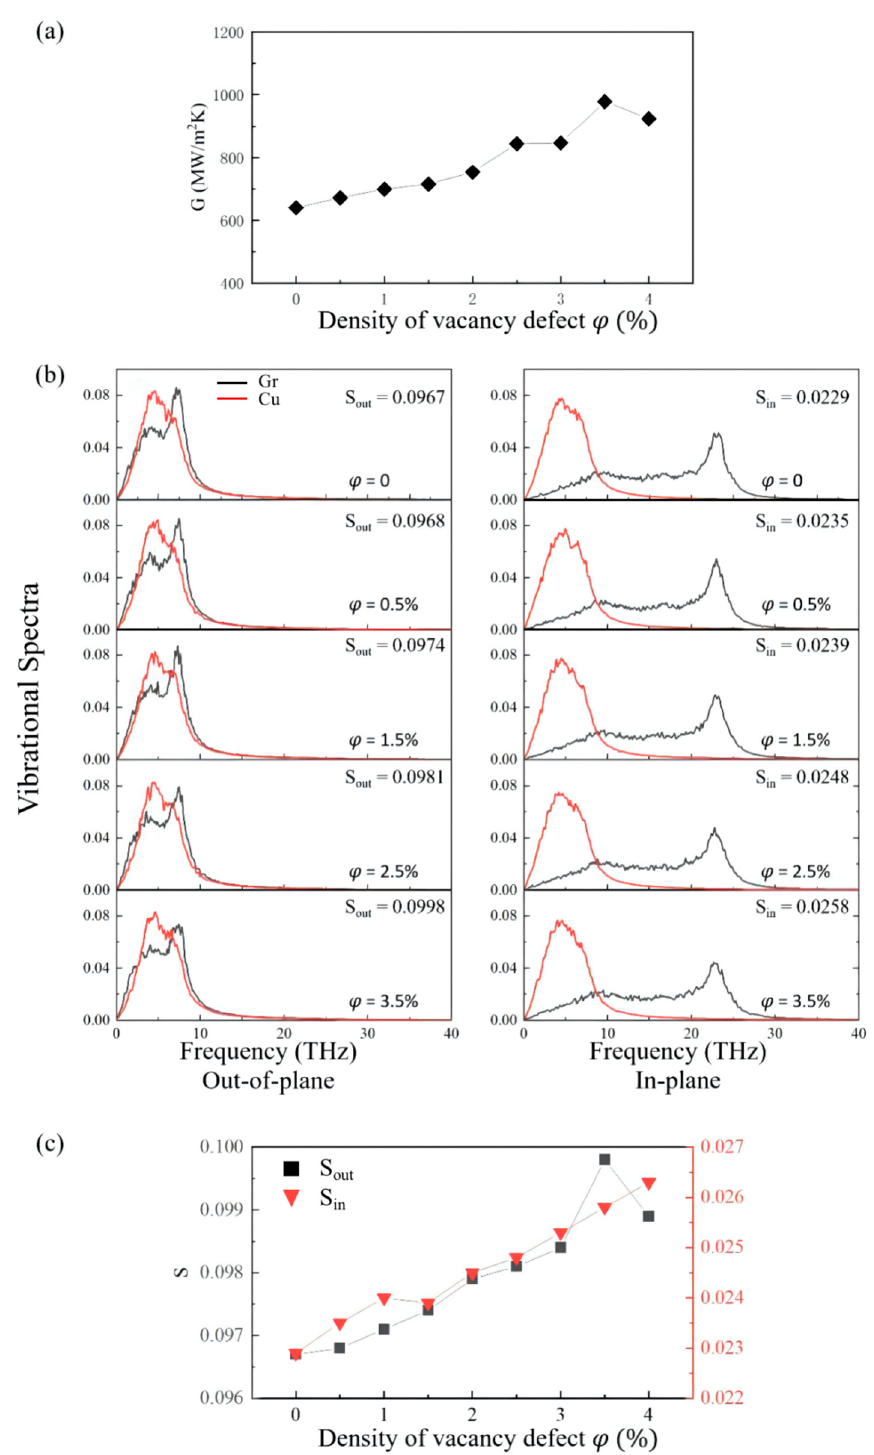
Figure 7. ( a ) Variation in Z-direction interfacial thermal conductance of graphene as a function of graphene defect density. ( b ) Out-of-plane and in-plane VDOS values of Cu and graphene atoms at the interface with diverse density of vacancy defect. ( c ) The overlap of phonon spectrum S with different density of vacancy defect; S out and S in represent the corresponding values of in-plane and out-of-plane modes, respectively.